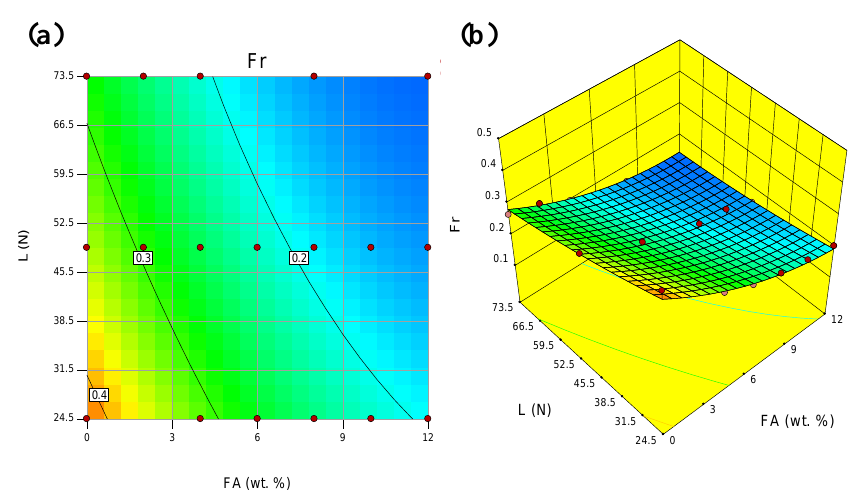
Figure 9. FA and L contour showing the interactive effect on the Fr, ( a ) contour lines 2D, ( b ) 3D.